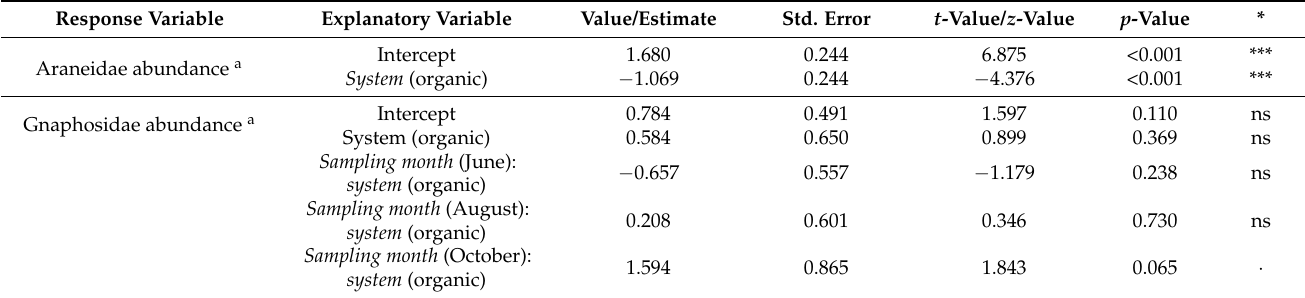
Table 3. Results of the different linear models for the abundance of the most dominant